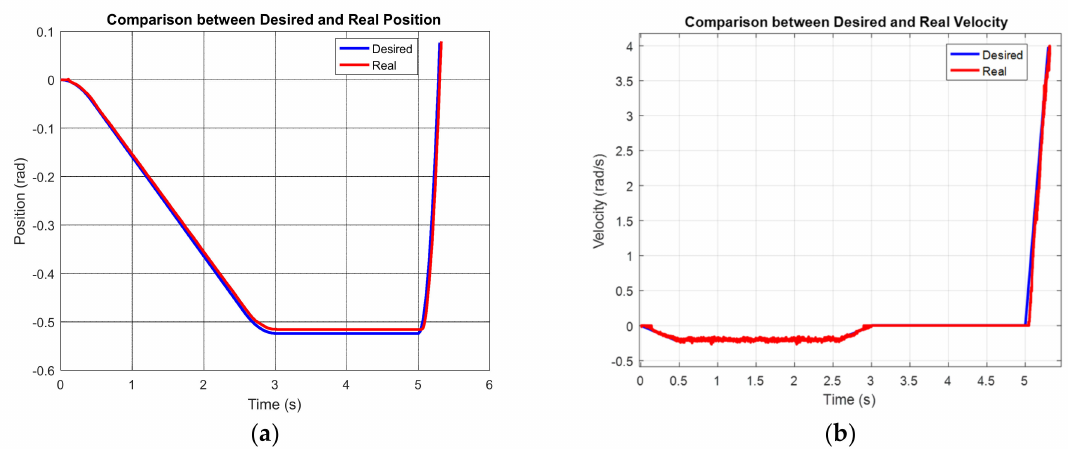
Figure A5. Implementation evidence of the developed real-time control system: ( a ) position profile and ( b ) velocity profile of the impactor.